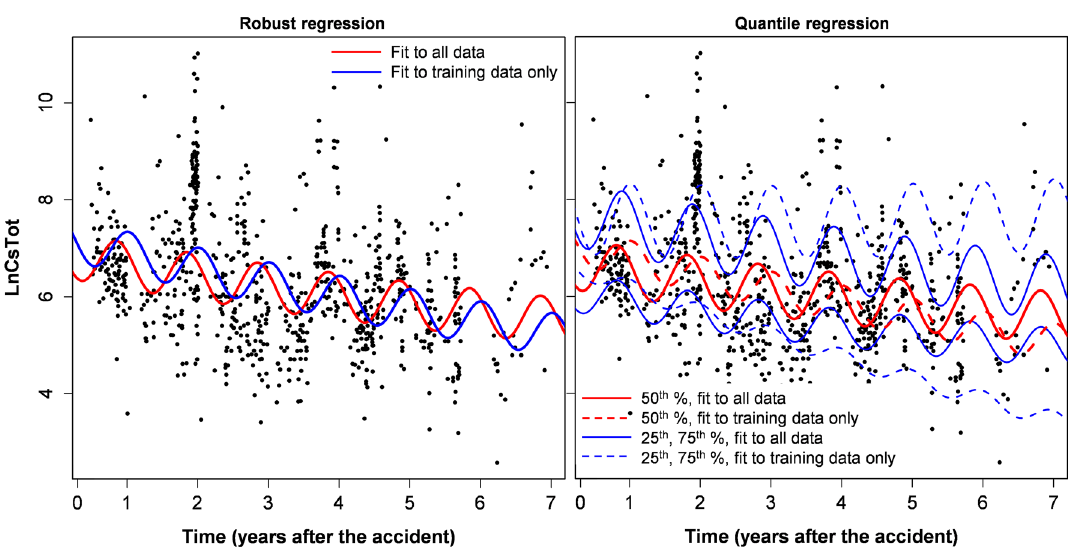
Figure 2. Robust and quantile regression analyses for wild boar ( Sus scrofa ) data for specific locations (Soso and Kenpoku districts) with high average radioactive cesium